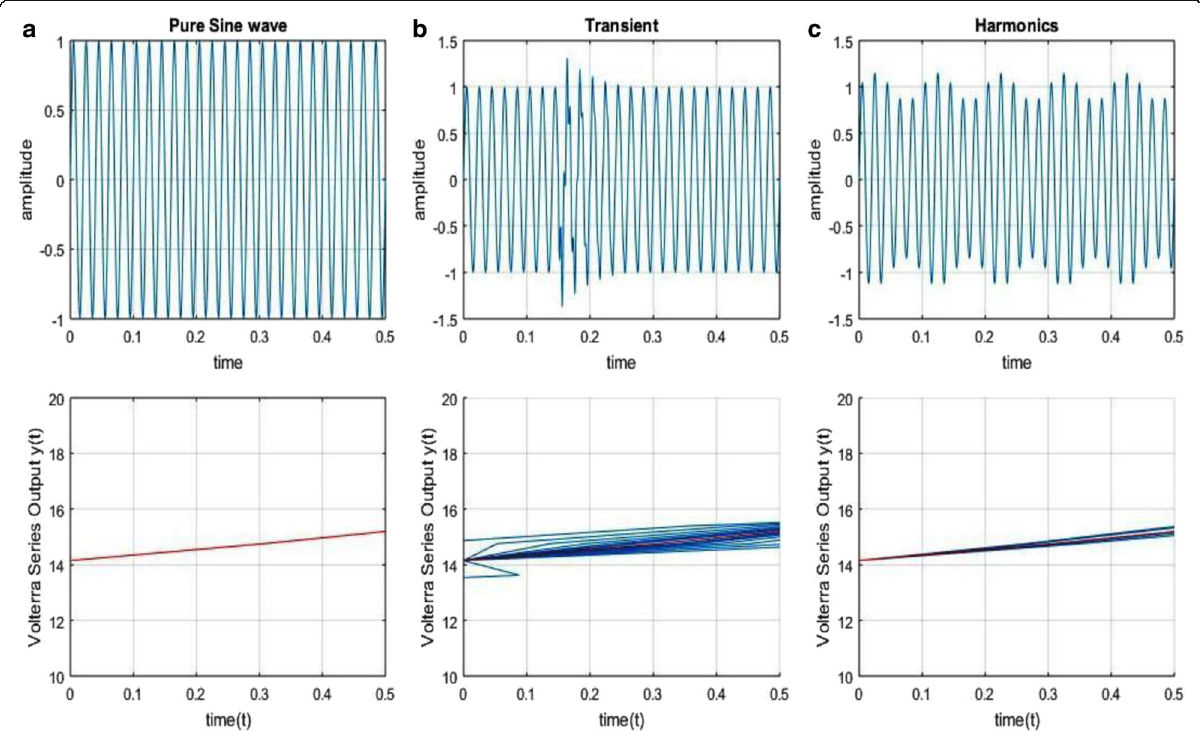
Fig. 2 Volterra series output for a Pure sine wave b Transient c Harmonics